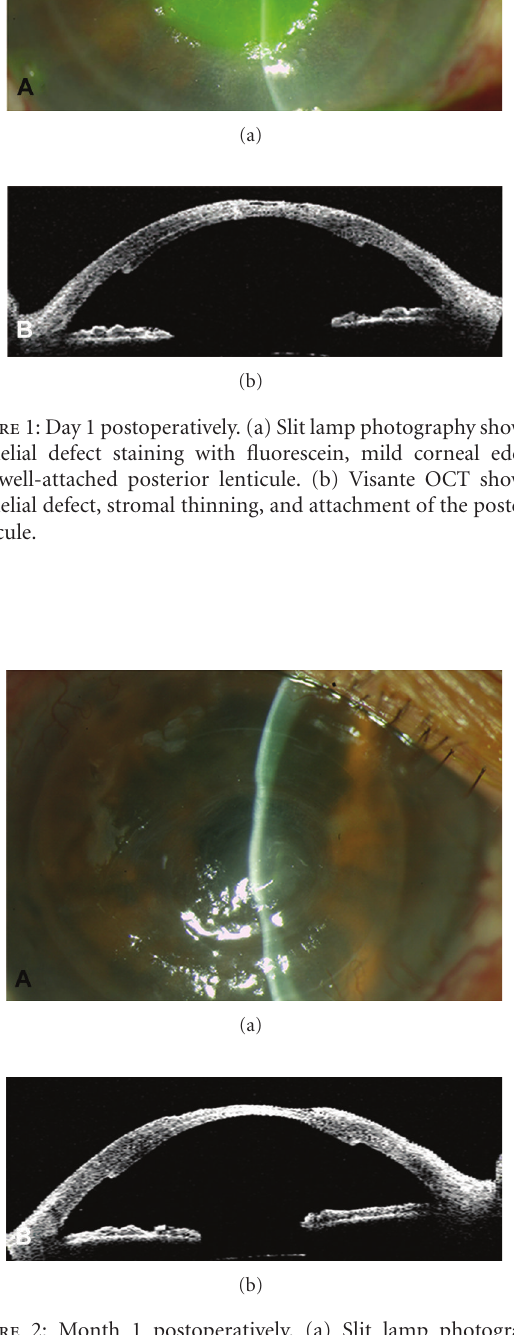
Figure 2: Month 1 postoperatively. (a) Slit lamp photography showing an integrated amniotic membrane graft, stromal thinning and adhered endothelial graft. (b) Visante OCT showing integrated amniotic membrane graft, stromal thinning, and well-attached endothelial